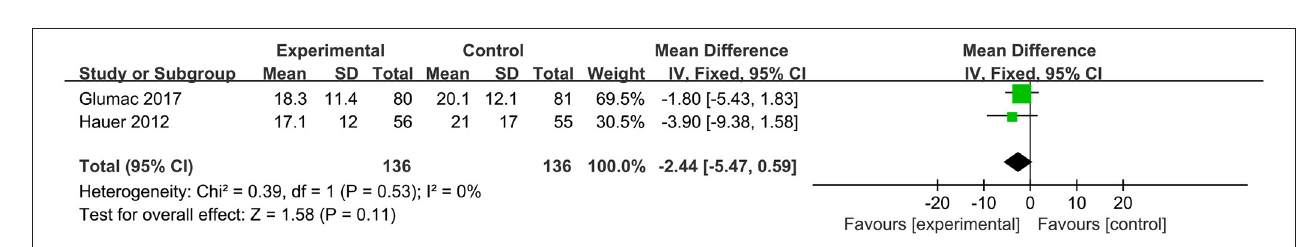
FIGURE 10 | Forest plot of duration of mechanical ventilation.